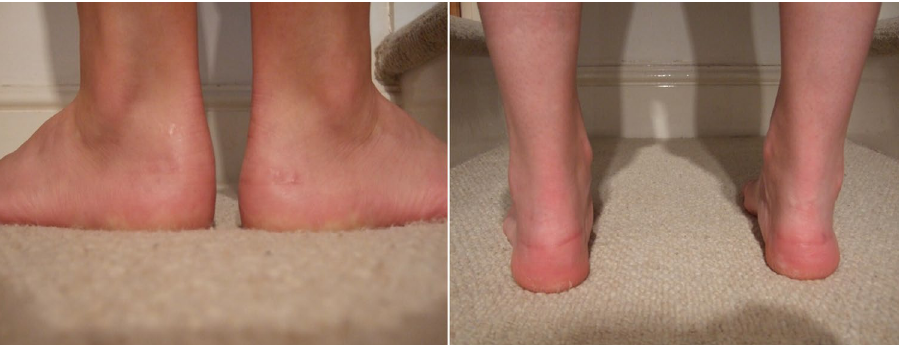
Figure 2. Failed lateral endoscopic approach revised with Cincinnati (right: pre-operative, left: 7 months post-